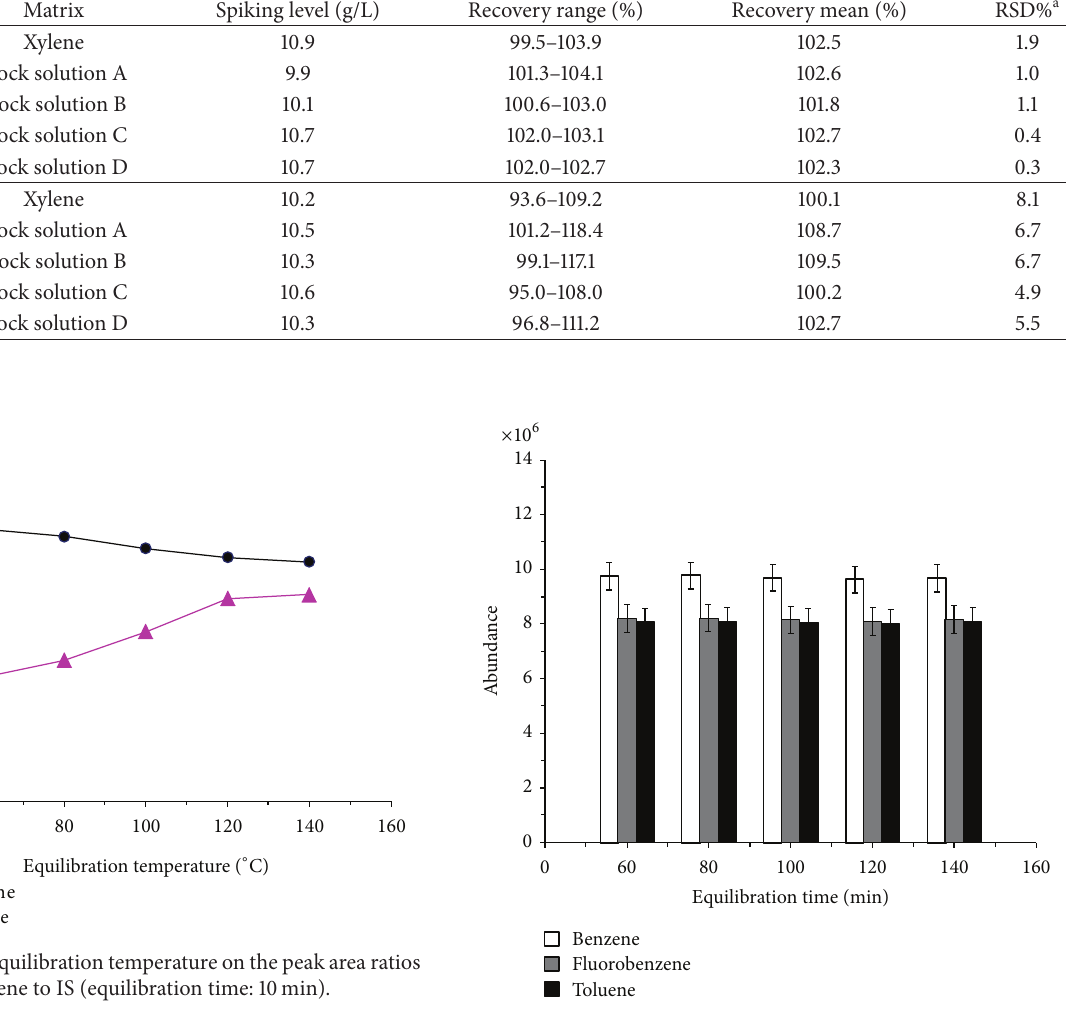
Figure 4: Effect of equilibration time on benzene, toluene and IS peak abundance (equilibration temperature: 120 ∘